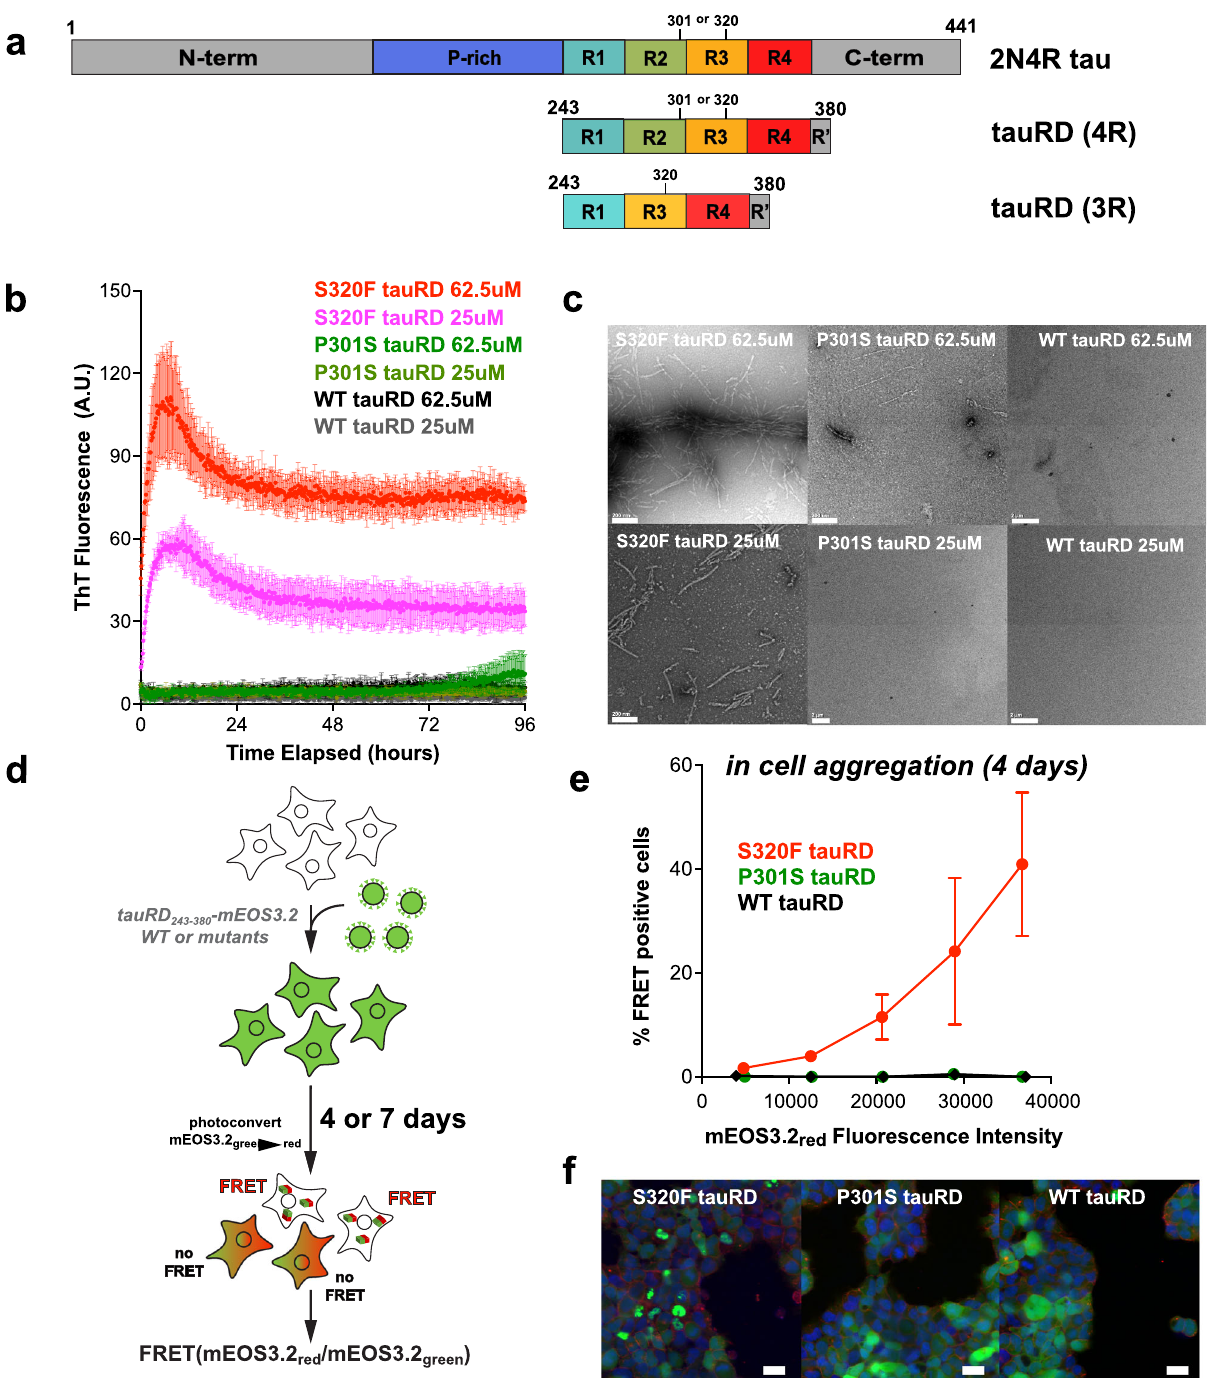
Fig. 1 | S320F causes spontaneous tau aggregation in vitro and in cells. a Schematic of 2N4R tau and tauRD where colored as follows: N-term=gray, proline-rich (P-rich)=purple, repeat-1=cyan; repeat-2=green; repeat-3=orange; repeat-4=red, R ’ =gray, C-term=gray. Relative positions of 301 and 320 are indi- cated by black bars. b ThT fl uorescence assay on S320F (red and magenta), P301S (green and olive), and WT (black and gray) tauRD at 62.5 µ M and 25 µ M, 37°C. The data are presented as an average+/ − SD for n =3 biological replicates.